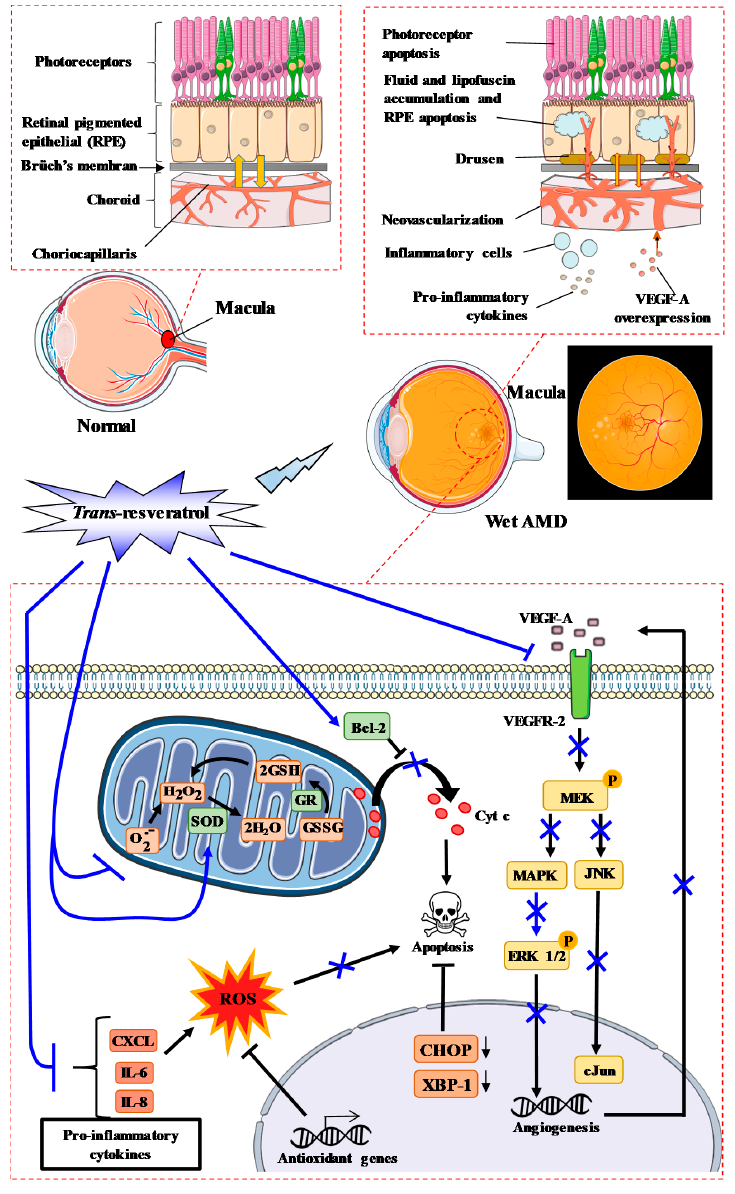
Figure 3. RSV could prevent oxidative stress involved in the development and progression of ocular diseases such as age-related macular degeneration (AMD). Various environmental factors produce free radicals, leading to oxidative stress in ocular tissues and consequently provoking the initiation of diseases such as AMD. On the one hand, RSV is able to scavenge free radicals (O 2 − ) and activate superoxide dismutase (SOD) or glutathione reductase (GR), while on the other, it inhibits inflammation through the reduction of various pro-inflammatory cytokines and blocks the signaling pathway induced by vascular endothelial growth factor-A (VEGF-A) to promote neoangiogenesis.